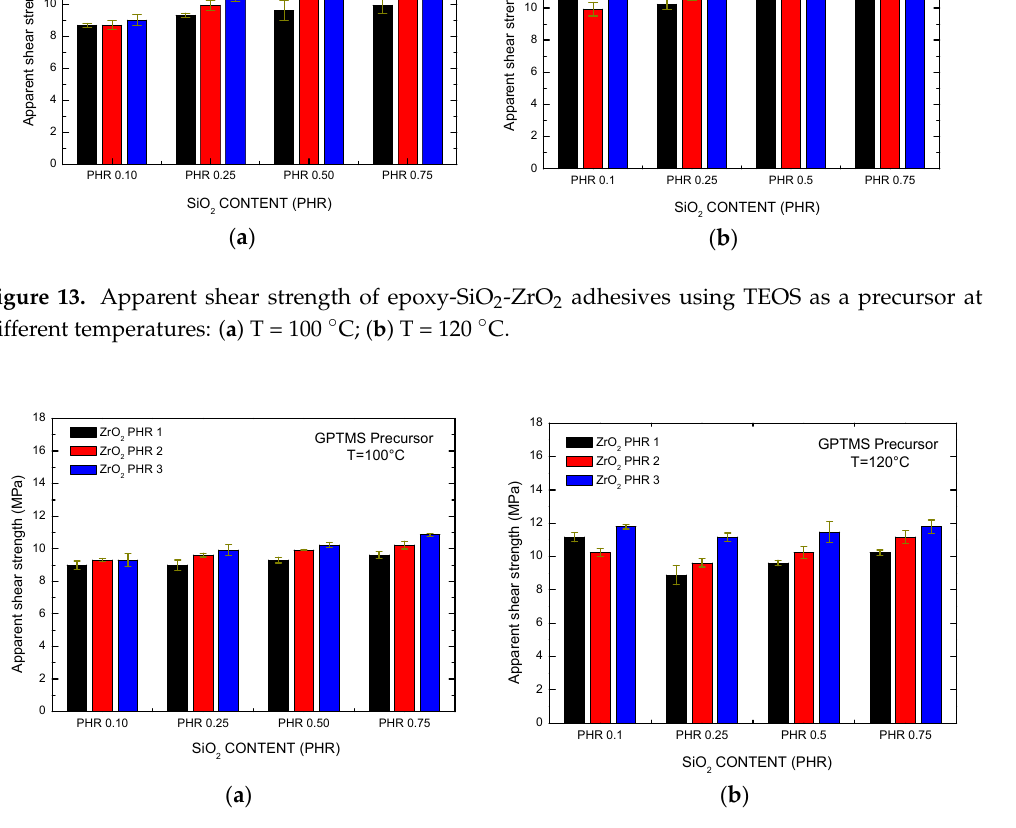
Figure 13. Apparent shear strength of epoxy-SiO 2 -ZrO 2 adhesives using TEOS as a precursor at different temperatures: ( a ) T = 100 °C; ( b ) T = 120 °C.